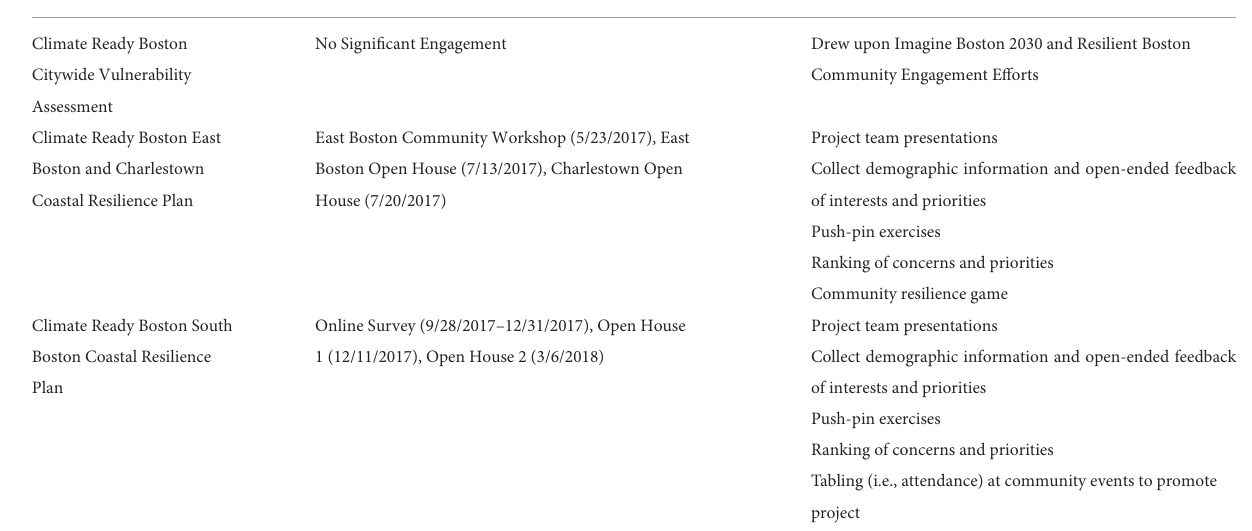
TABLE 3 Summary of community engagement